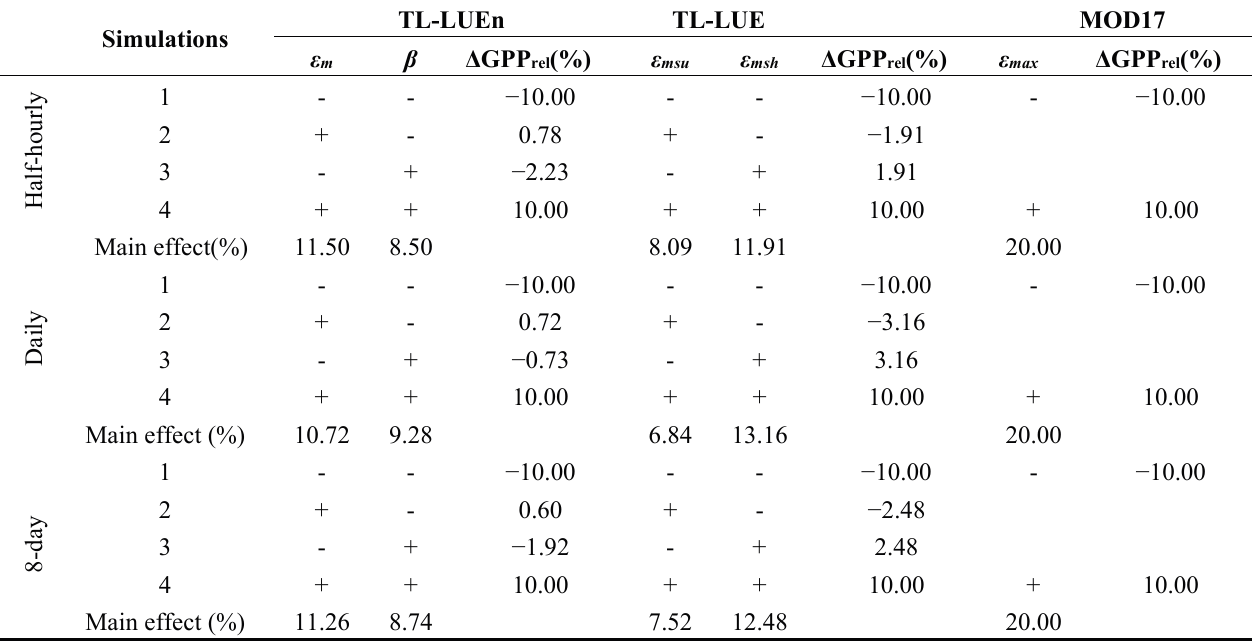
Table 5. Design of the 2 2 complete factorial sensitivity analyses for parameters of TL-LUEn, TL-LUE with all the vegetation types lumped together at half-hourly, daily, and 8-day